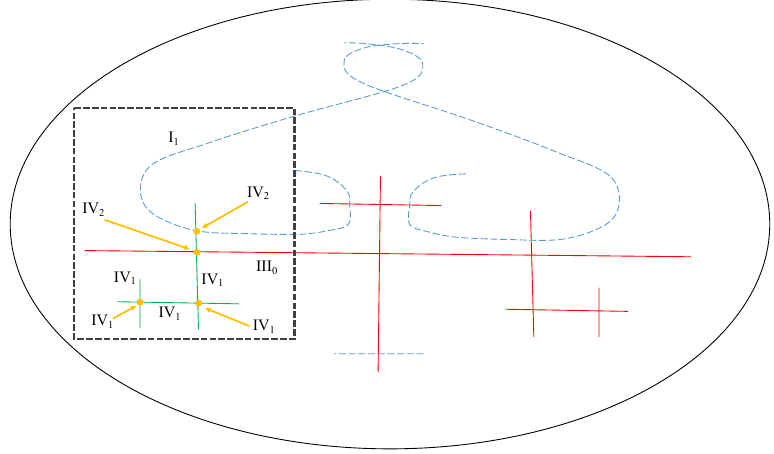
Figure 3 . Figure showing an example intersecting network for the (mirror of the) Calabi-Yau P 1 ; 1 ; 1 ; 6 ; 9 [18] as studied in [23]. In this case we focus in one a particular region of the network, within the box, and show the more re(cid:12)ned data for each locus including the sub-index. At the points of intersections the type of a locus can be modi(cid:12)ed. We show the types associated to each intersection point in the focused